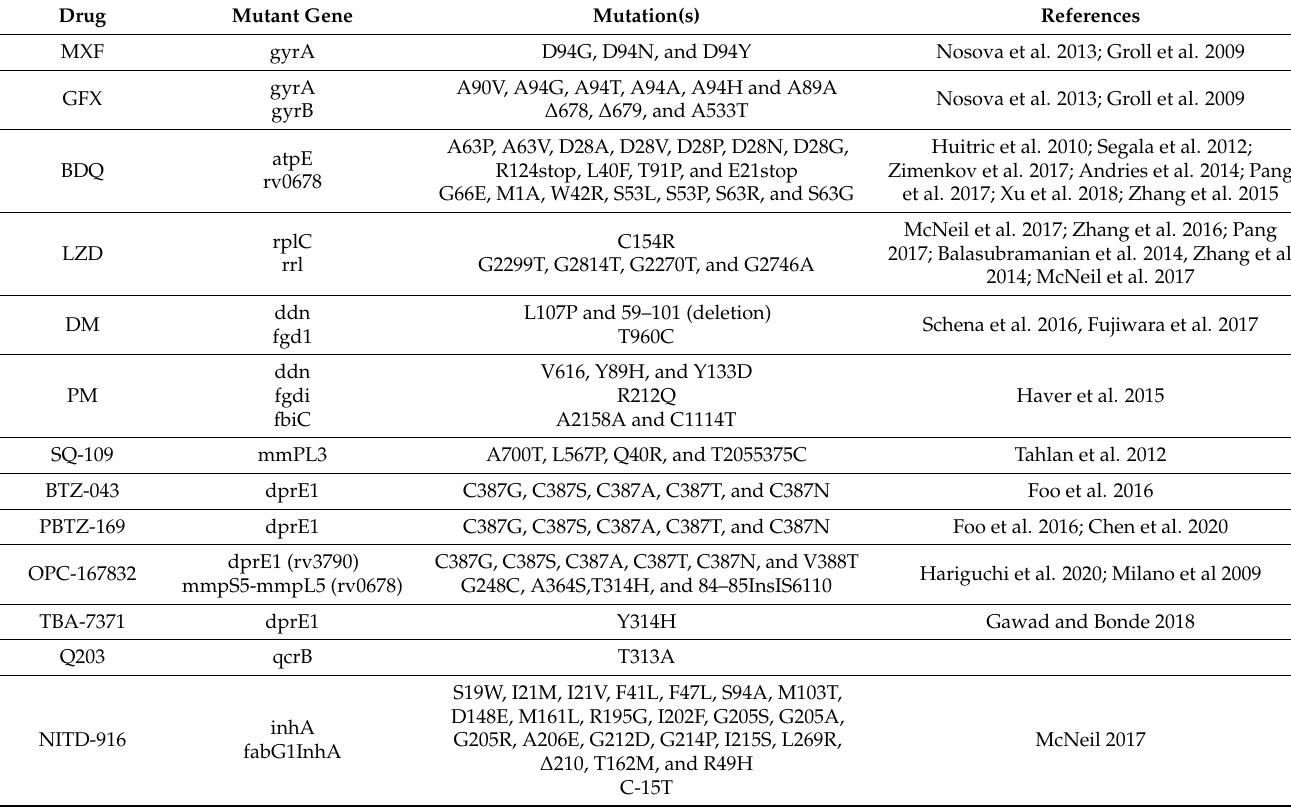
Table 1. Mutant genes and Mutations causing Mtb resistance to novel anti-TB drugs under development.